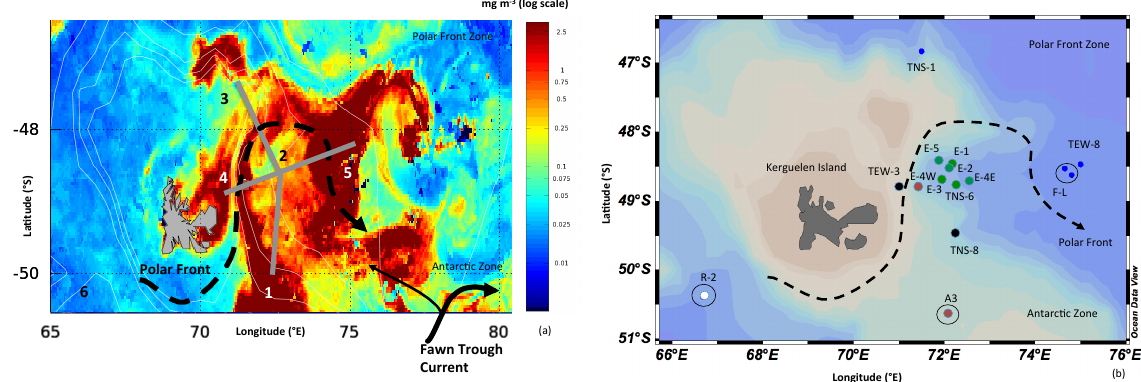
Figure 1. (a) Kerguelen Island area in the Southern Ocean with KEOPS 2 sampling zones and MODIS chlorophyll concentrations (mgm − 3 ) (Chl a map from 11 November 2011, courtesy of F. d’Ovidio) superimposed. 1 refers to station A3; 2 to stations E; 3 to the south–north transect; 4 to the west–east transect; 5 to station F-L and 6 to reference station R-2; (b) Corresponding stations location. Colours indicate stations with similar θ − S and Chl a